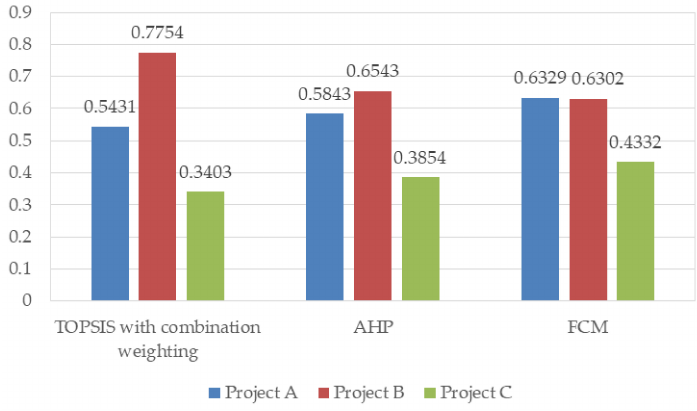
Figure 7. Evaluation result comparison of different methods.